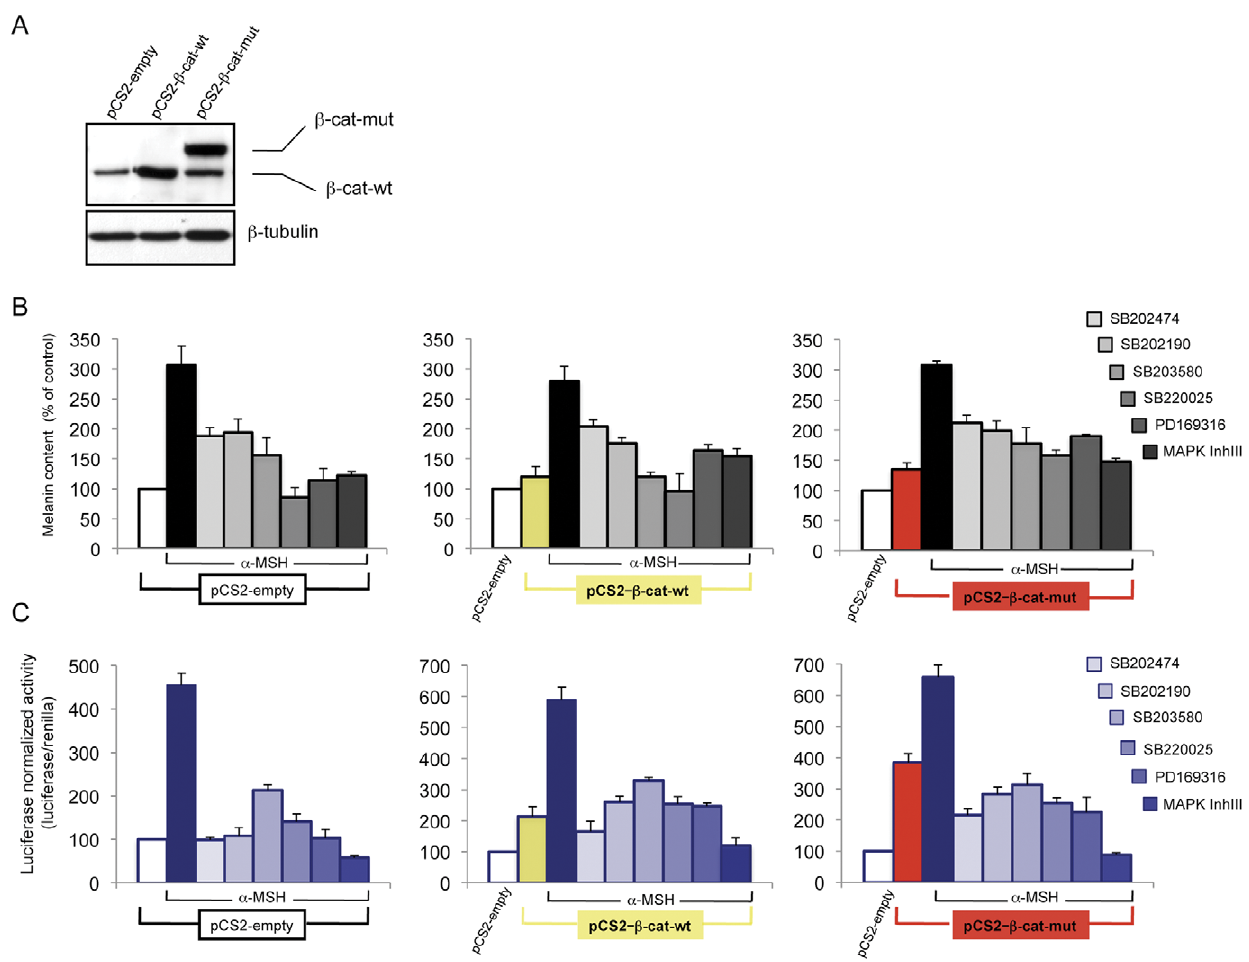
Figure 7. The effect of forced b -catenin expression on pyridinyl imidazoles-dependent melanogenesis inhibition. Western blot analysis of b -catenin in whole-cell lysates prepared from B16-F0 cells transfected with pCS2- b -cat-wt, pCS2- b -cat-mut plasmids or pCS2 empty vector. Total cellular proteins (30 m g/lane) were subject to 10% SDS-PAGE. Variation of loading was determined by blotting with anti- b -tubulin antibody. Western blot assays are representative of at least three experiments. (B) Twenty-four hours after transfection cells were treated with a -MSH (0.1 m M) in presence of pyridinyl imidazoles (SB202474, SB202190, SB203580, SB220025, PD169316 20 m M: MAPK Inh III 10 m M) for 72 h, or not, and then the extracellular and intracellular levels of melanin were determined as described above. The data show the mean 6 SD of three independent experiments performed in duplicate. (C) B16-F0 cells were cotrasfected with lucerase reporter plasmids TopFlash and pCS2- b -cat-wt, pCS2- b -cat-mut plasmids. The pTK-Renilla was inserted as an internal control for each experimental sample as a control for transfection efficiency. Firefly luciferase activity, normalized to the renilla luciferase activity was expressed as fold decrease compared with control cells. Values represent mean 6 SD of three representative experiments performed in